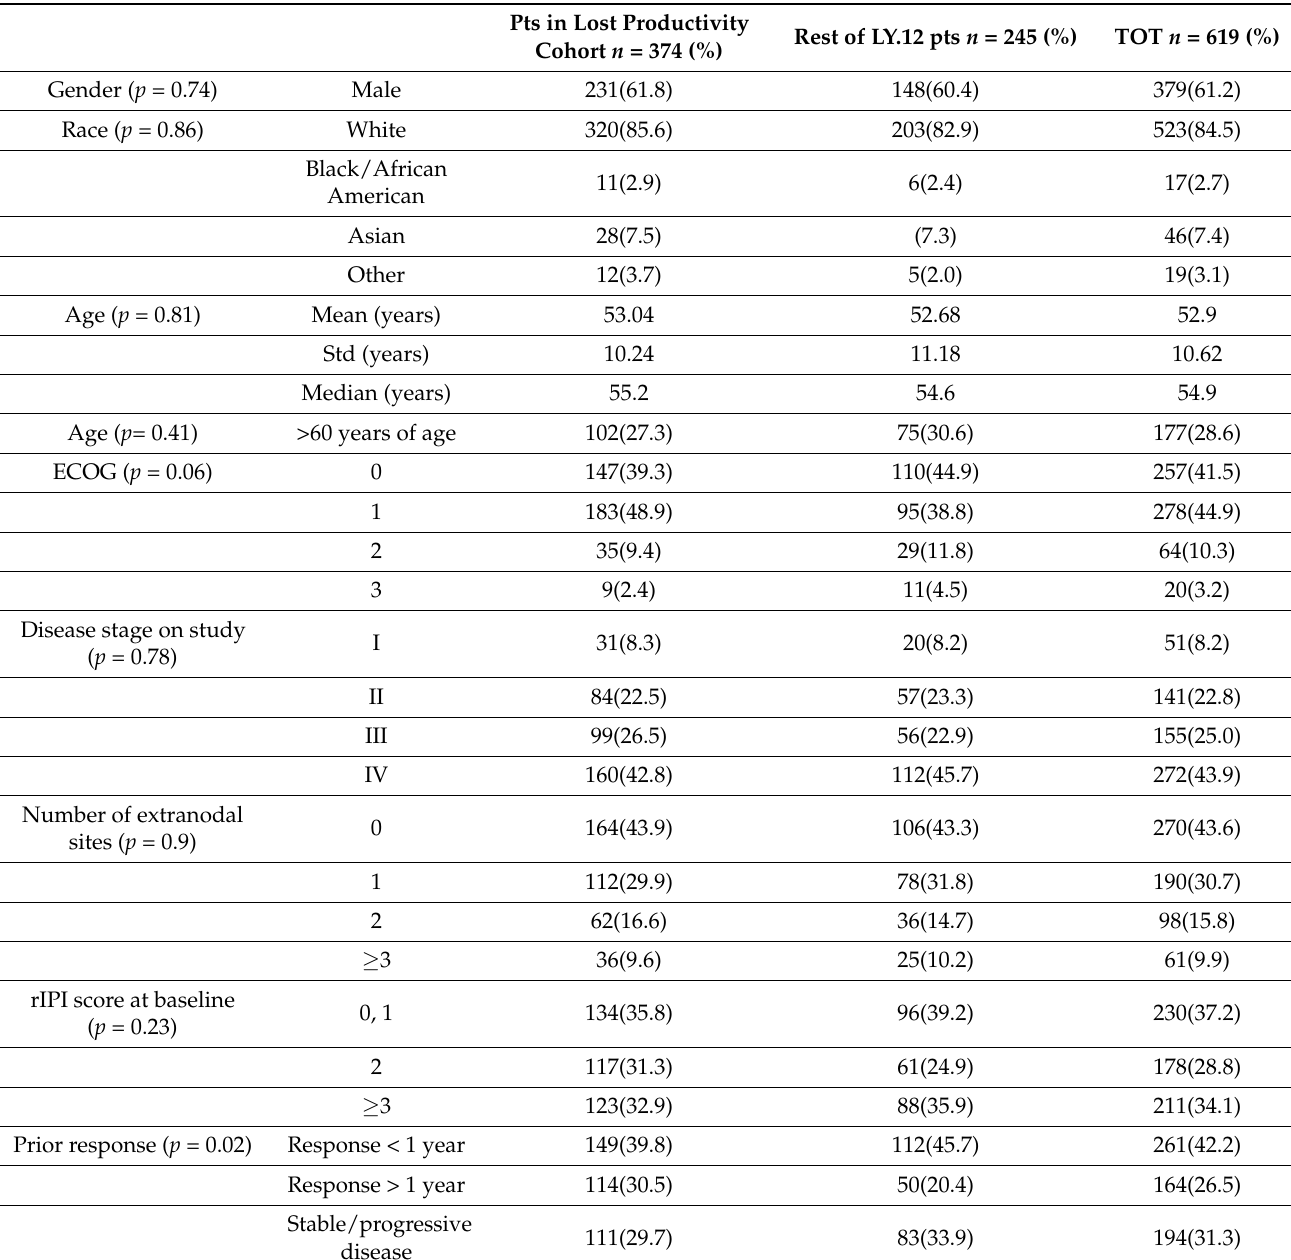
Table 1. Lost productivity cohort of pts vs. the rest of LY.12